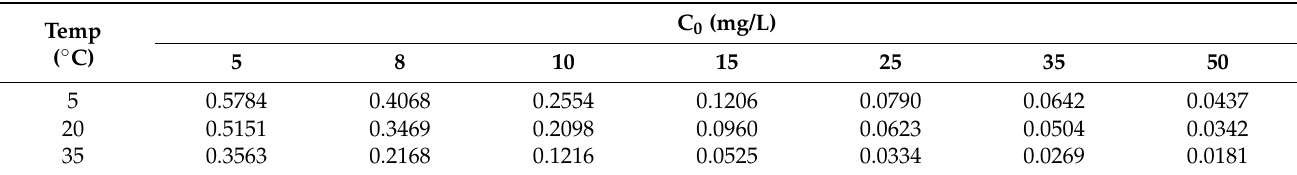
Table 5. Relation between the RL of bio-ceramsite and ammonium